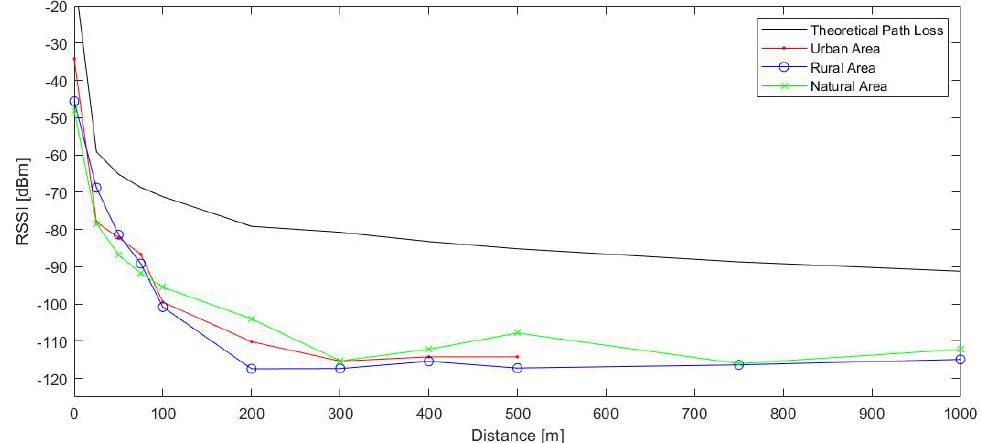
Figure 11. Comparison of theoretical and experimental RSSIs as a function of distance.